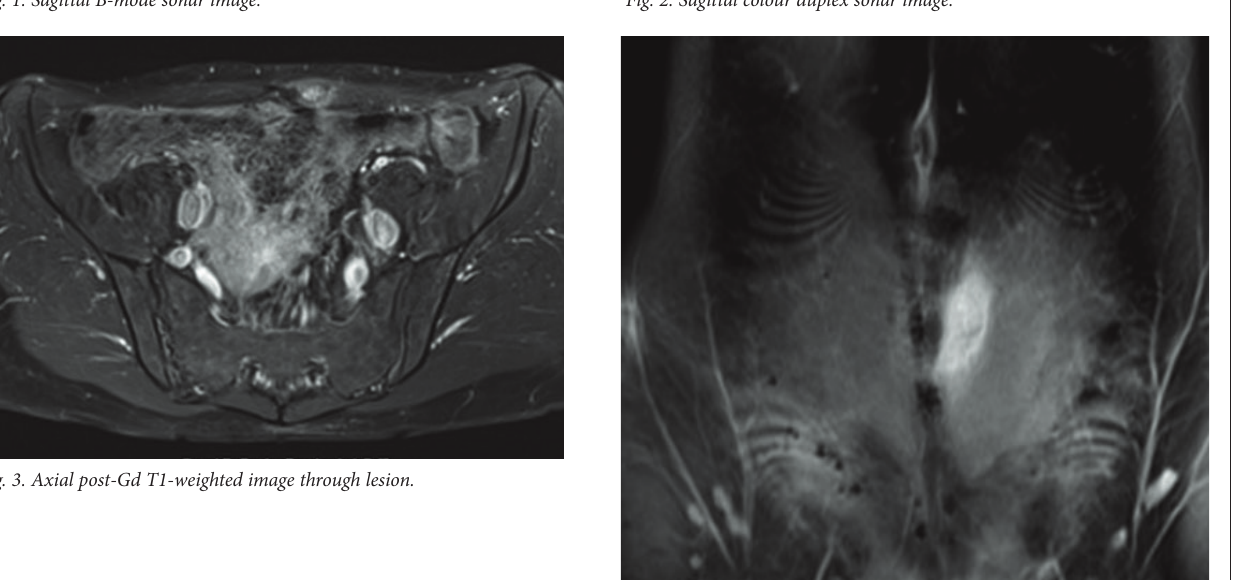
1. Sagittal B-mode sonar image. Fig. 2. Sagittal colour duplex sonar image.